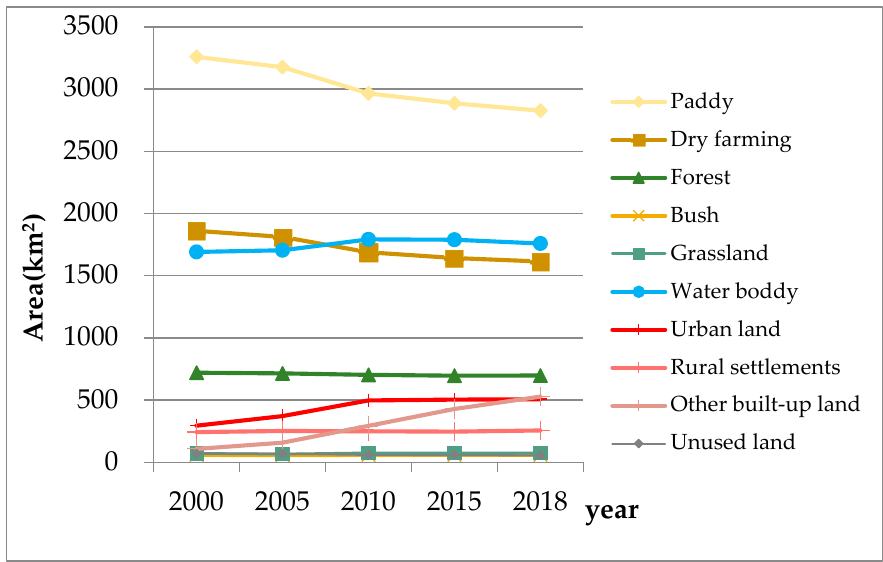
Figure 4. Change in the land use in Wuhan during 2000–2018.